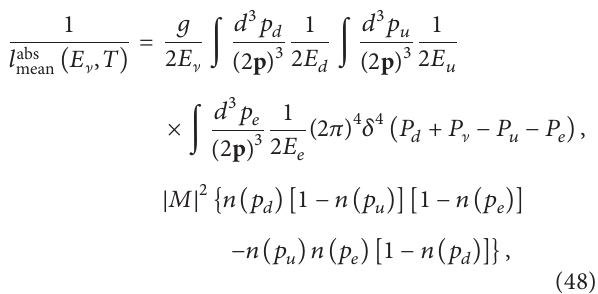
Figure 4: Energy dependence of the diffusion coefficient at 𝑇/𝑇 𝑓 = 1/3 (dotted curve), 𝑇/𝑇 (dash dotted curve)